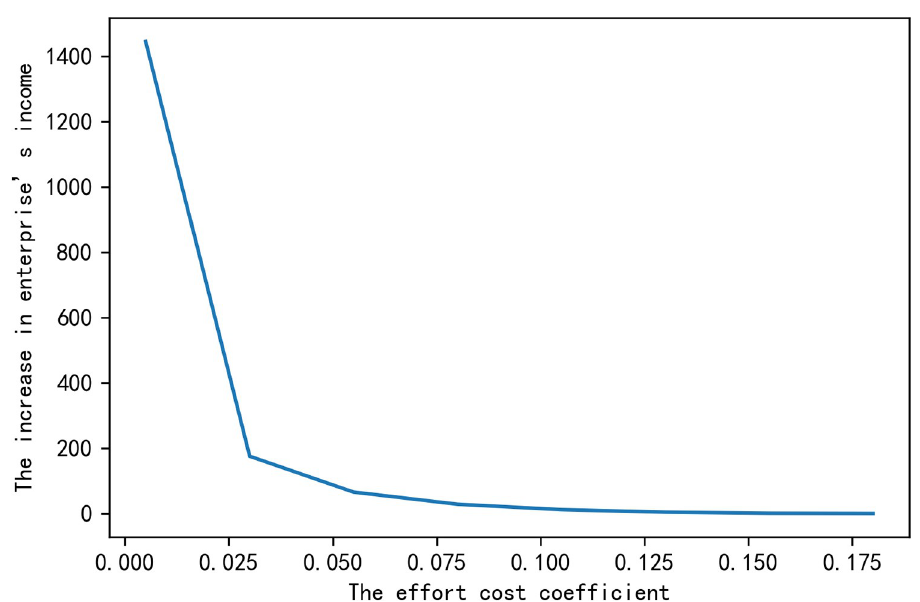
Fig 3. The impact of the effort cost coefficient on the increase in enterprise’s